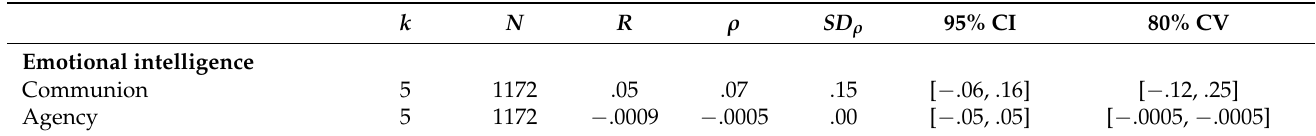
Table 5. Meta-analytic results for Emotional Intelligence with Agency and Communion.